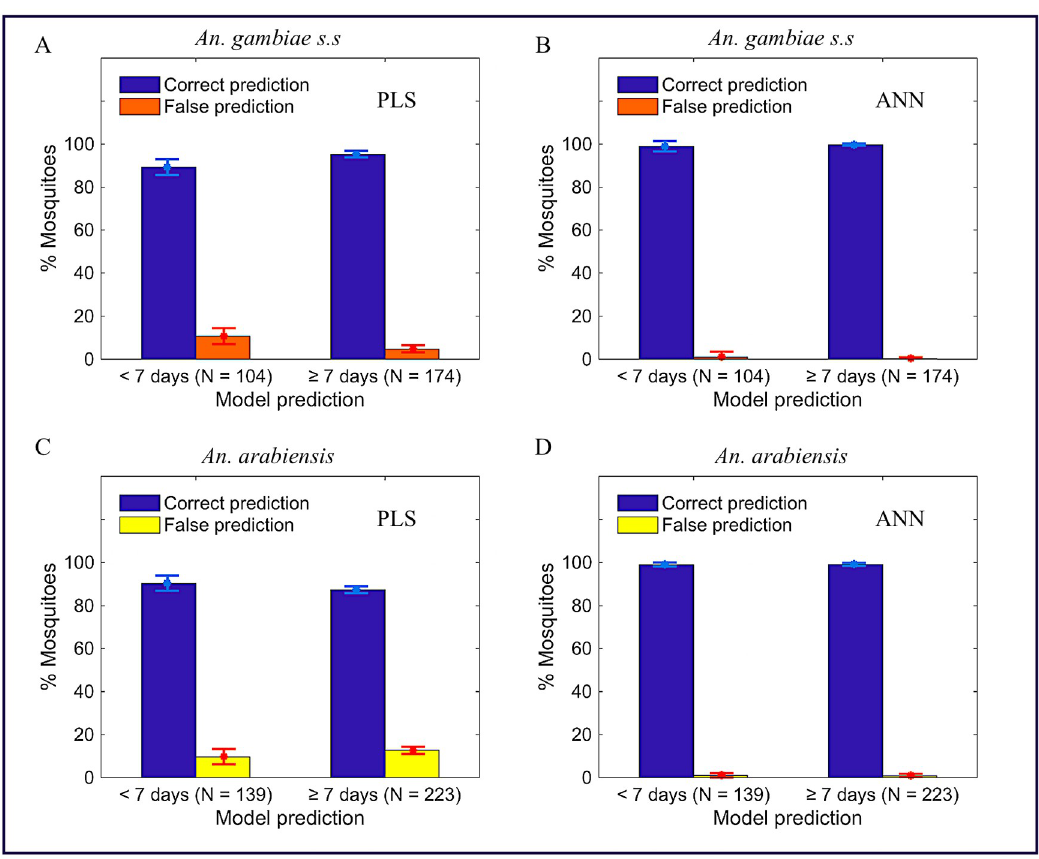
Fig 4. The number of correct and false predictions in each estimated age-class when directly trained PLS (A and C) and ANN (B and D) binary classifiers were applied to classify age of An . gambiae (A and B) and An . arabiensis (C and D) in testing sets. Results from ten replicates.